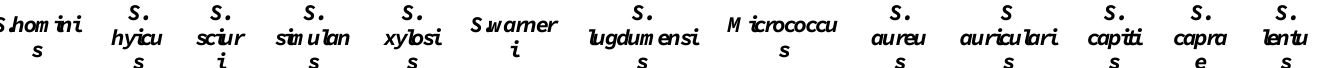
Table S1: Table of agreement between the 16S rRNA sequencing and the API tests for the identification of different NAS species. 16S